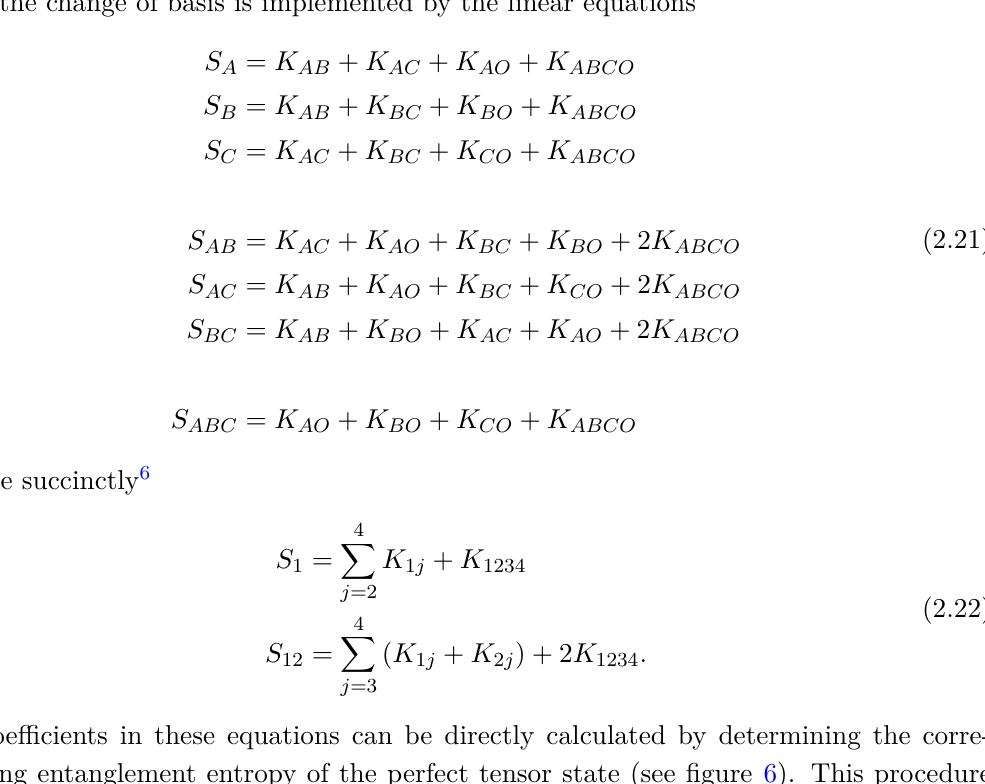
contains 1 K and 2 K as AB AC ABCO